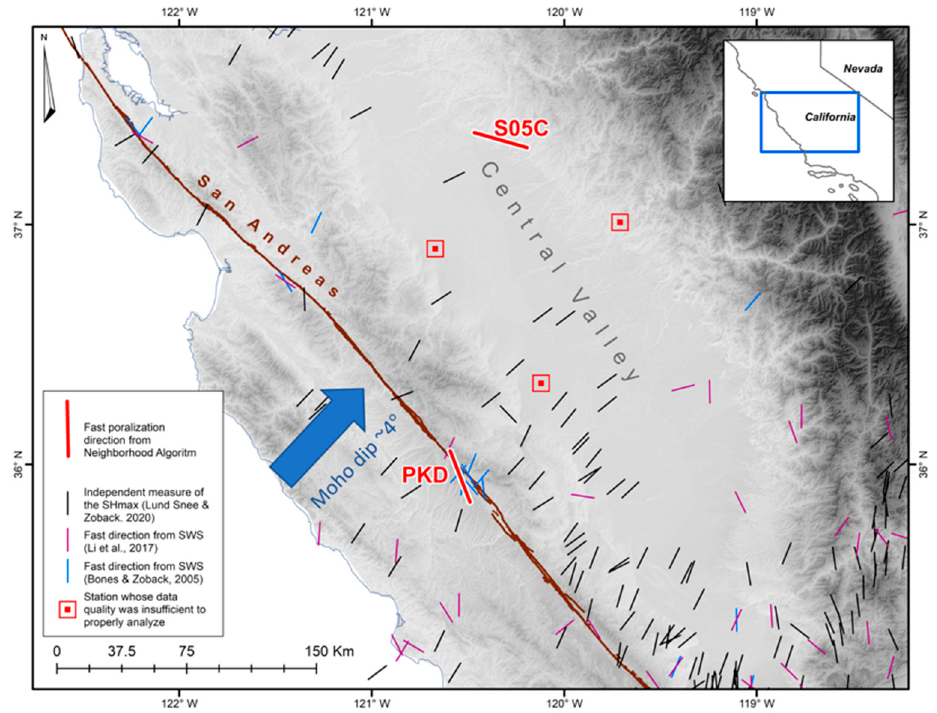
Figure 7. Map of the four US Transportable Array stations in the Central Valley plus the PKD station with independent stress indicators [3], Moho dip direction and magnitude [26] and fast polarization directions [14,15]. “SWS” signifies shear-wave splitting.